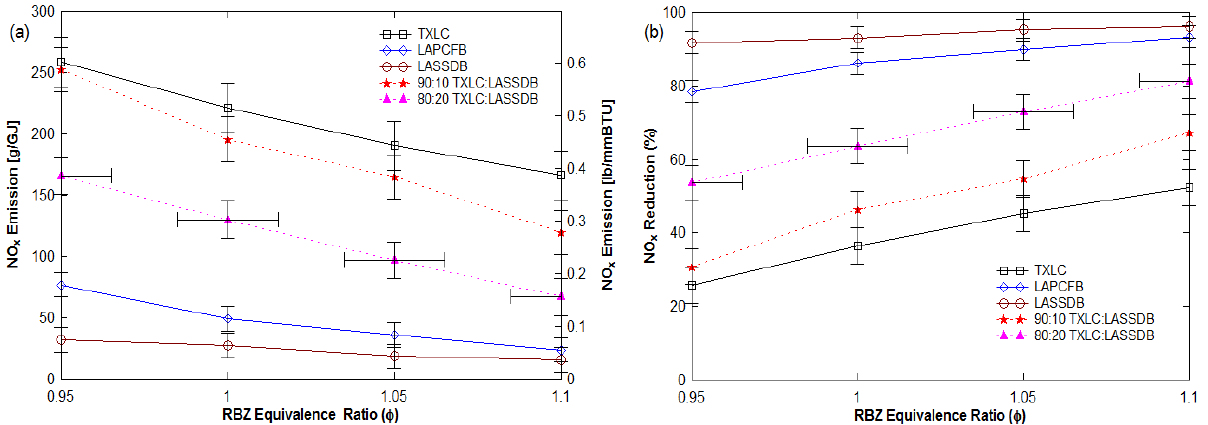
Figure 8. NO x control with the reburn fuels (non-vitiation, 30% reburn heat input and 0° reburn injection): ( a ) NO x emission and ( b ) NO x reduction on a heat basis.